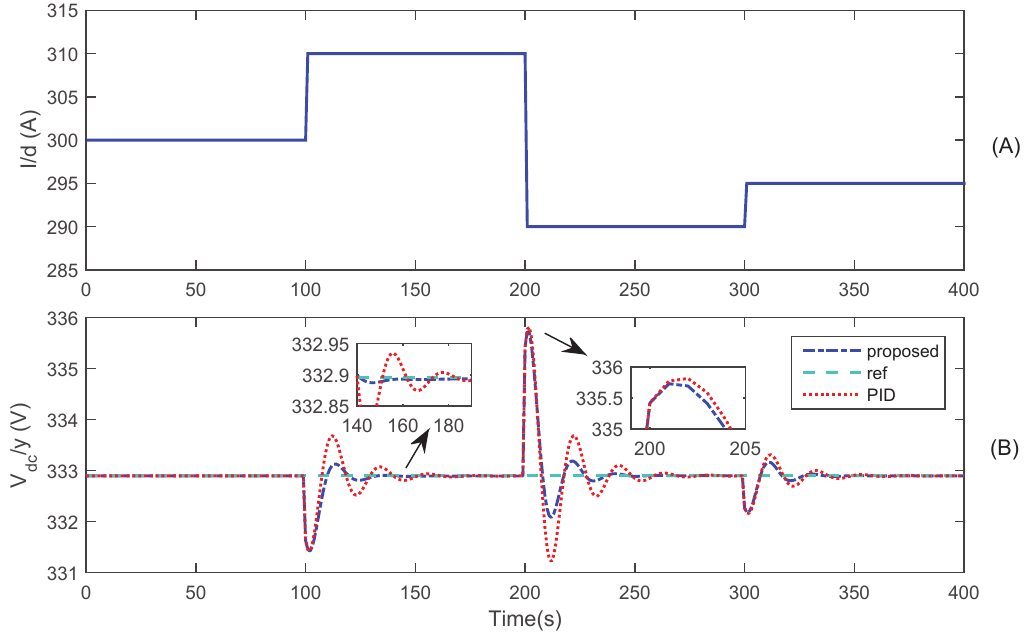
Figure 6. Current load I ( A ) and the voltage tracking curves of the SOFC of proposed control method compared with the conventional PID control ( B